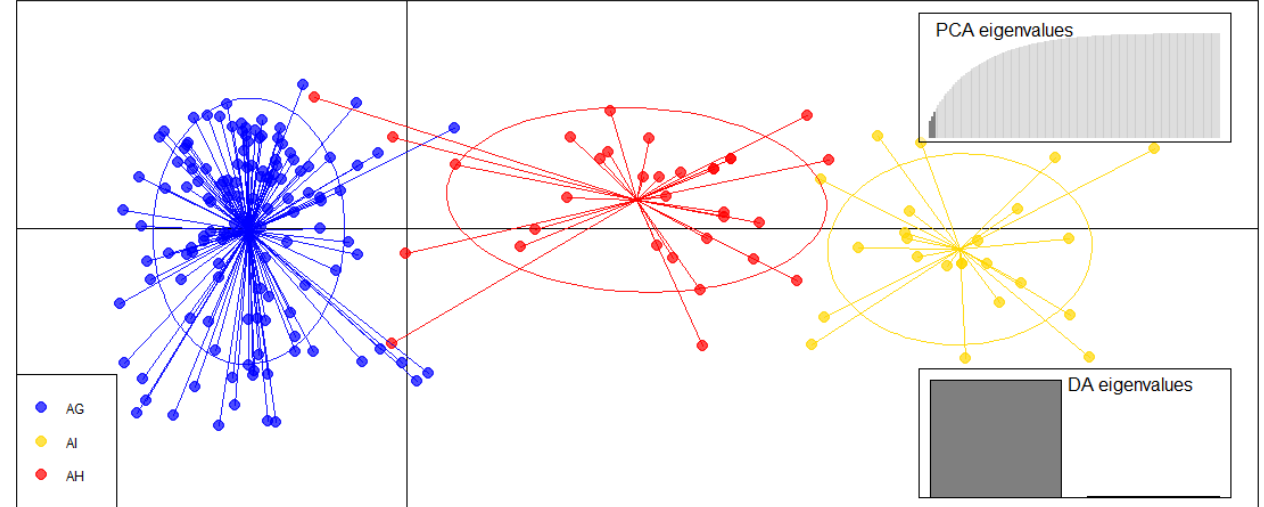
Figure 4. Discriminant analysis of principal components (DAPC) of three Alnus spp. groups based on fifteen microsatellite